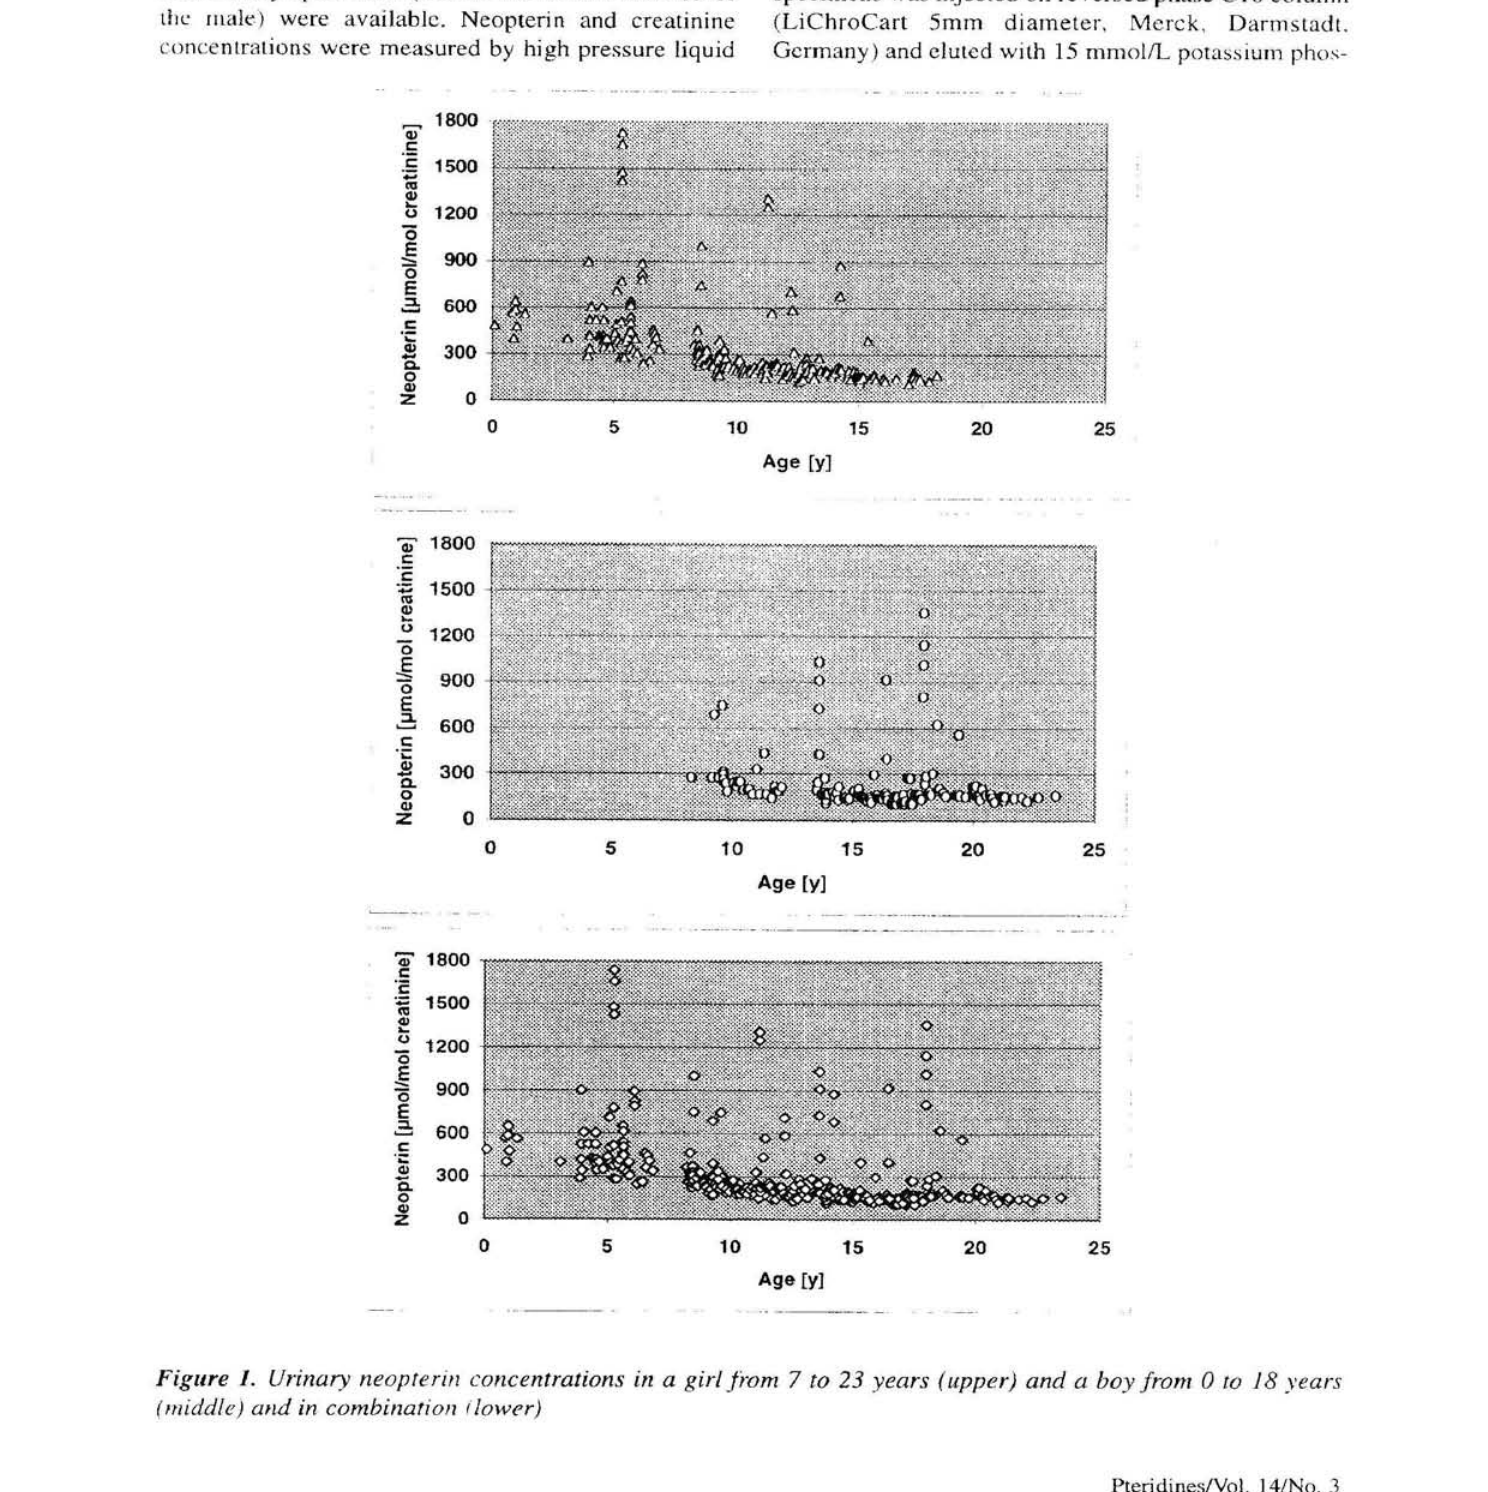
Pteridines/Vol. 14/No.